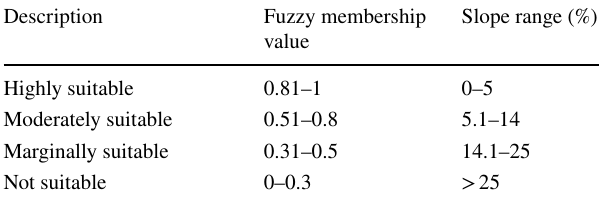
Table 2 Criteria for the classification of slope